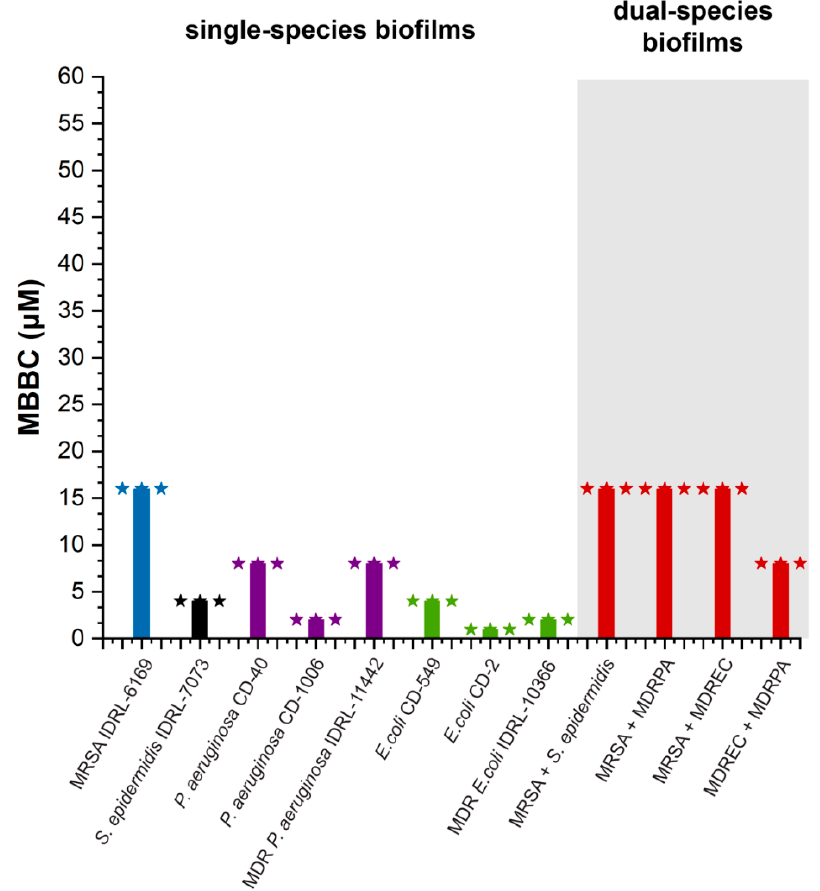
Figure 2. MBBC values of PNPs against mono-species (Gram-positive: MRSA, S. epidermidis ; Gram-negative: P. aeruginosa , E. coli ) and dual-species biofilms (MRSA IDRL-6169 + S. epidermidis IDRL-7073; MRSA IDRL-6169 + P. aeruginosa IDRL-11442; MRSA + E. coli IDRL-10366; P. aeruginosa IDRL-11442 + E.coli IDRL-10366). Bars represent average of three values, and stars represent individual measurements.